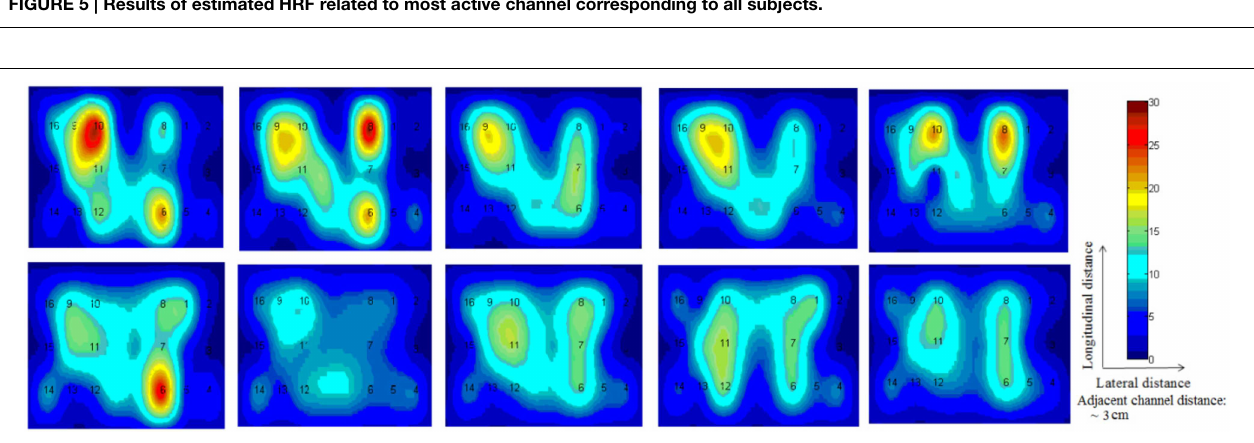
FIGURE 6 | t -Maps of each subject and all